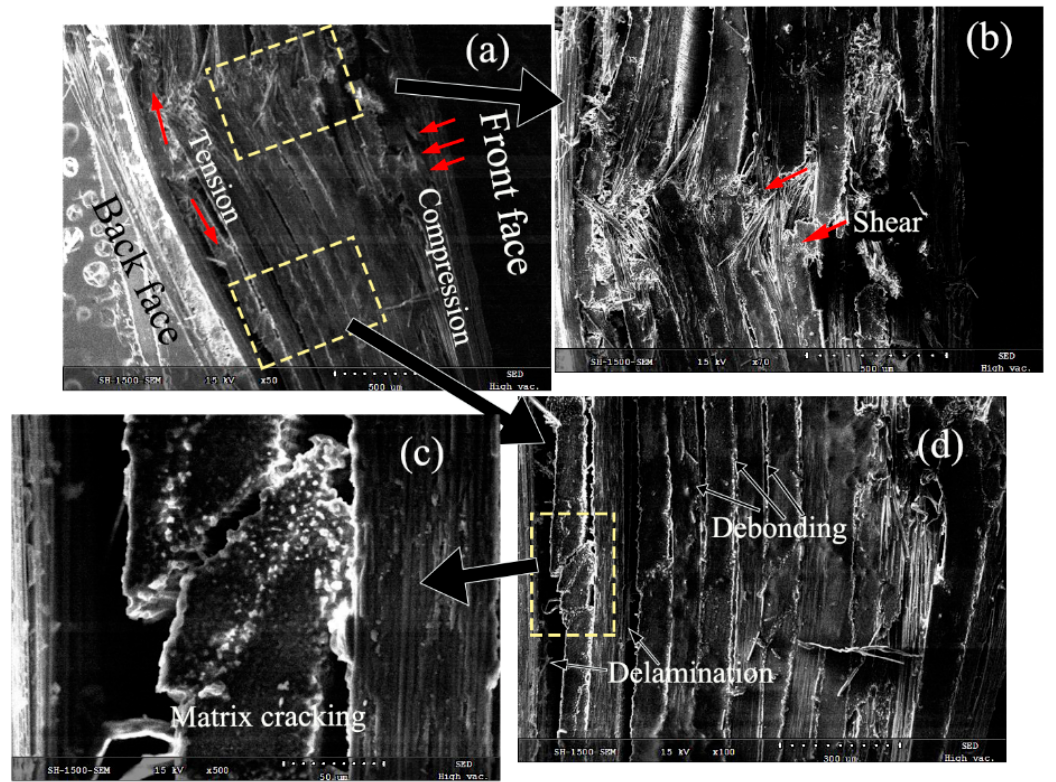
Figure 15. Fracture patterns of the dry specimen subjected to the impact velocity of 45 m/s using the SEM technique. ( a ) Compressive damage; ( b ) Shear damage; ( c ) Matrix cracking; ( d ) Extensive debonding and